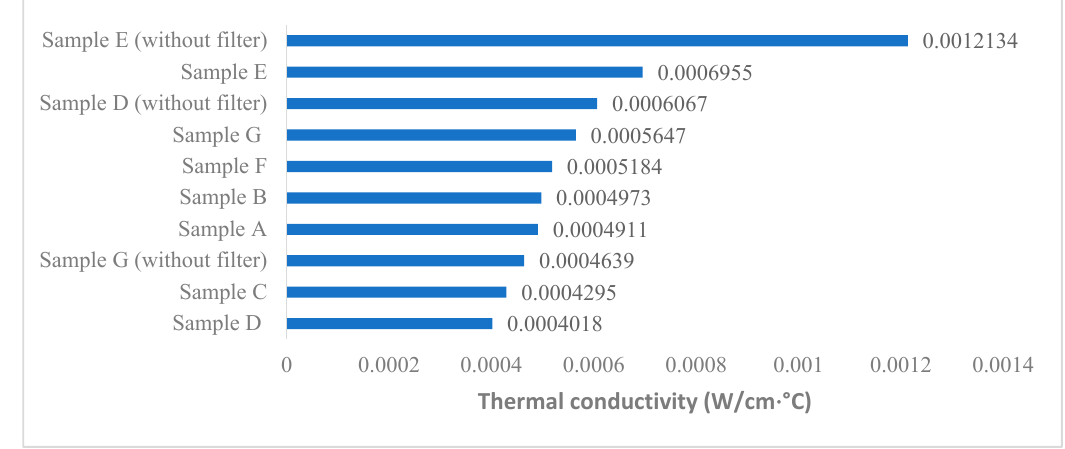
Figure 4. Thermal conductivity of different masks.